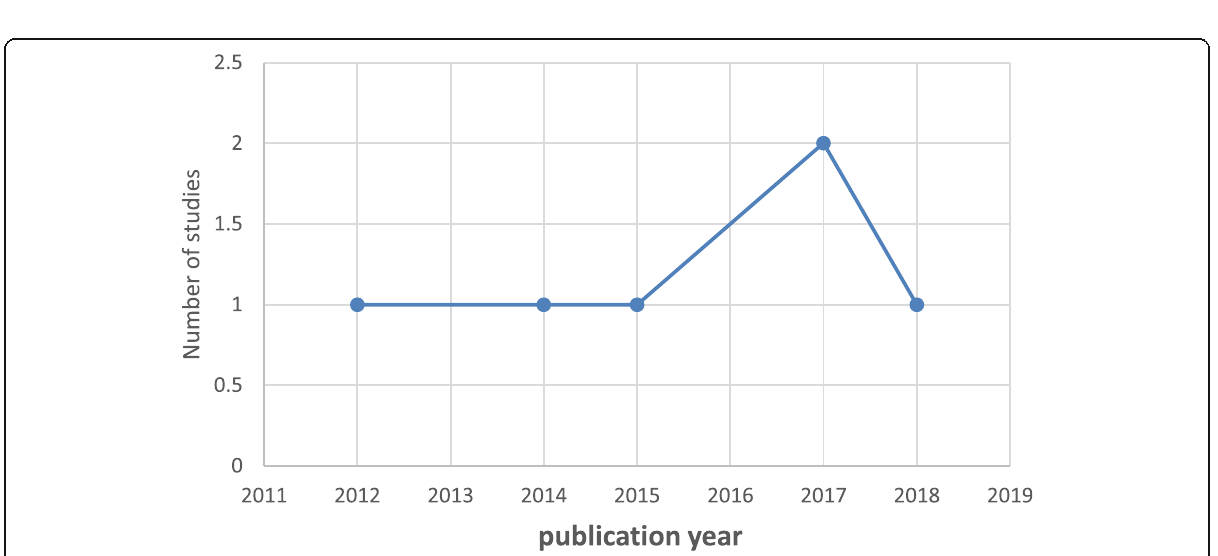
Fig. 3 Number of published studies on neglected tropical diseases using electronic technology per